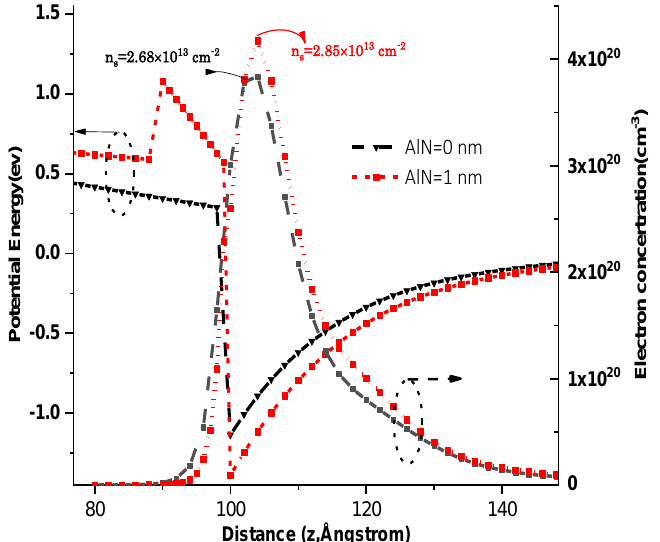
Figure 5. The electron concentration and conduction band distribution of In 0.12 Al 0.88 N/AlN/GaN with different AlN thicknesses.